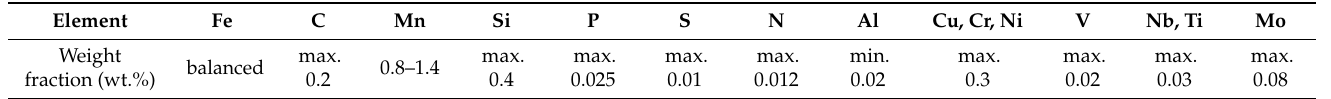
Table 1. Chemical composition of the P265GH steel according European Standard EN 10028-2:2017. Element Weight fraction (wt.%)